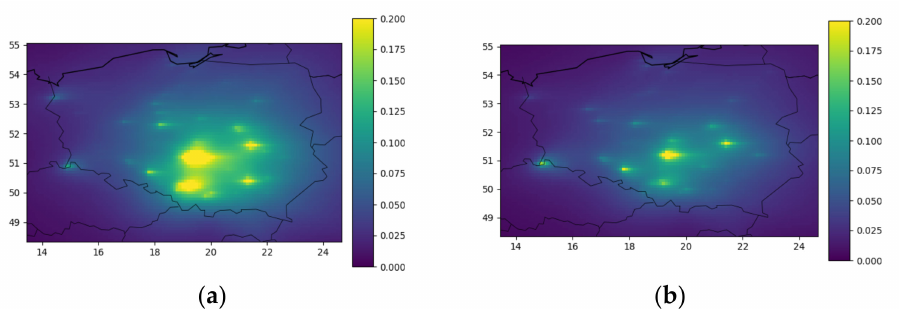
Figure 3. The ambient NO x (sum of NO 2 , NO, and N 2 O) concentration at surface level resulting from the emissions of the power sector in ( a ) 2018 and ( b ) 2030, according to the non-nuclear scenario ( µ g/m 3